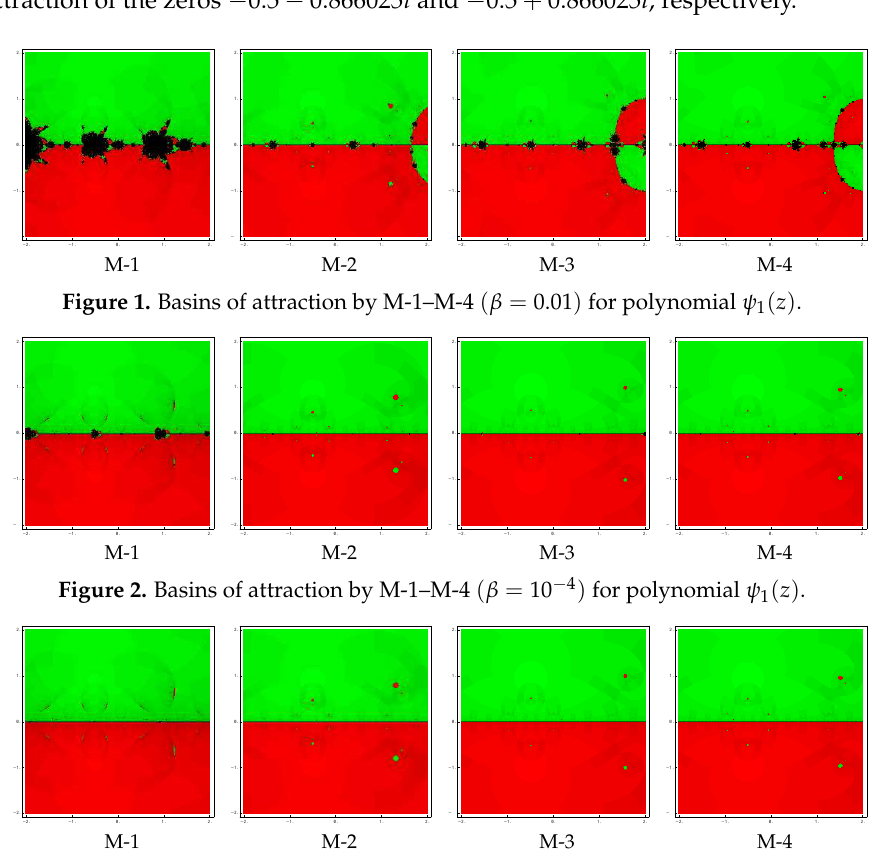
Figure 3. Basins of attraction by M-1–M-4 ( β = 10 − 6 ) for polynomial ψ 1 ( z ) .